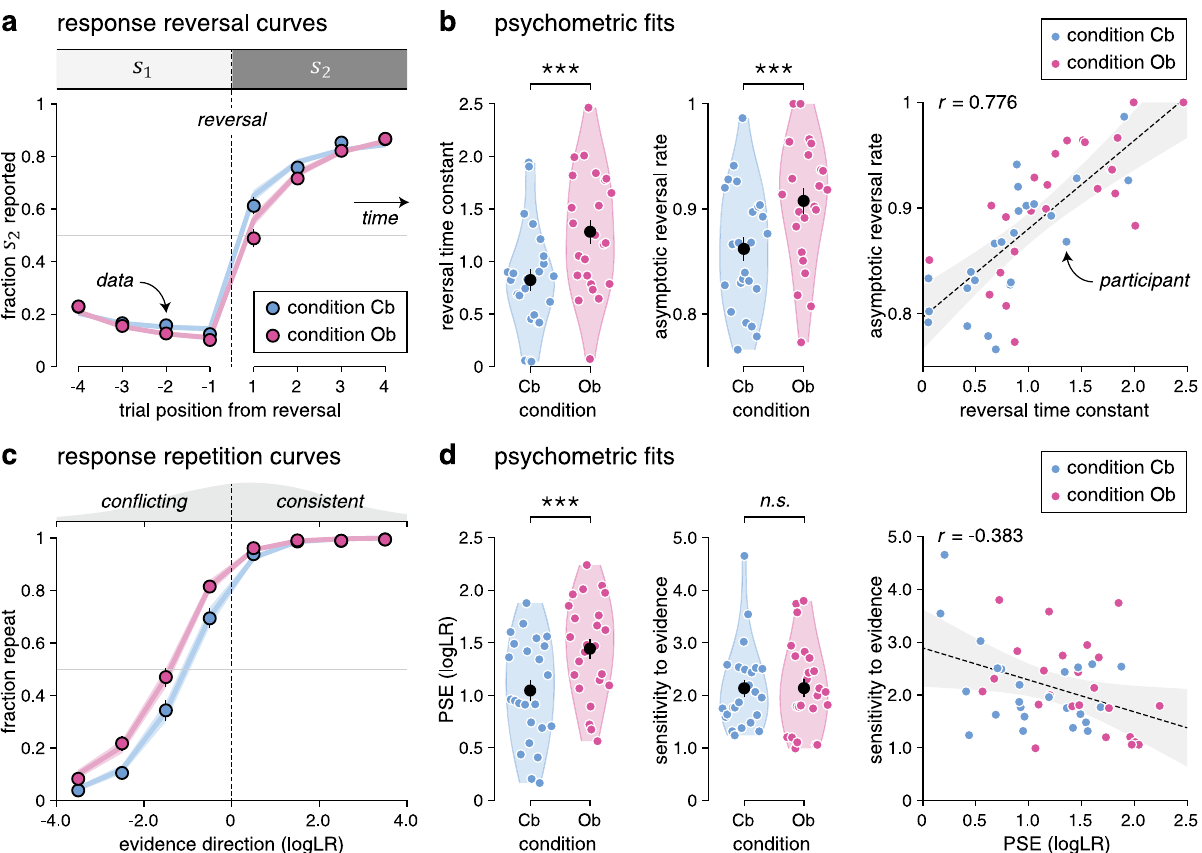
Fig. 2 Reversal learning behavior and psychometric fi ts. a Response reversal curves. Fraction of hidden state s 2 reported behaviorally ( y axis) in the four trials preceding (left) and following (right) a reversal from s 1 to s 2 ( x axis). The thin dotted line indicates the position of the reversal. Dots indicate the observed data (means ± SEM, n = 24 participants), whereas lines and shaded error bars indicate best- fi tting saturating exponential functions (means ± SEM, n = 24 participants). b Best- fi tting parameters of saturating exponential functions in the cue-based and outcome-based conditions. Black dots and error bars indicate group-level means ± SEM, whereas colored dots indicate participant-level estimates ( n = 24 participants). Left: the reversal time constant is longer and the asymptotic reversal rate is higher in the outcome-based condition. Right: the two parameters correlate positively across participants. The thin dotted line indicates the best- fi tting regression line and the shaded area its 95% con fi dence interval. c Response repetition curves. Fraction of response repetitions ( y axis) as a function of the evidence provided by the intervening sequence in favor of the previous response ( x axis, expressed as logLR). Positive evidence indicates evidence consistent with the previous response, whereas negative evidence indicates evidence con fl icting with the previous response. The thin dotted line indicates perfectly uncertain (null) evidence. Dots indicate the observed data (means ± SEM, n = 24 participants), whereas lines and shaded error bars indicate best- fi tting sigmoid functions (means ± SEM, n = 24 participants). d Best- fi tting parameters of sigmoid functions in the cue-based and outcome-based conditions. Left: the PSE is increased in the outcome-based condition, whereas the sensitivity to evidence is matched across conditions. Right: the two parameters correlate slightly negatively across participants. Signi fi cant effect at ***p < 0.001; n.s., a nonsigni fi cant effect (paired two-sided t -tests, d.f. = 23, no correction for multiple comparisons). The error band indicates the 95% con fi dence interval for the regression line fi tted using ordinary least squares. Source data are provided as a Source Data fi